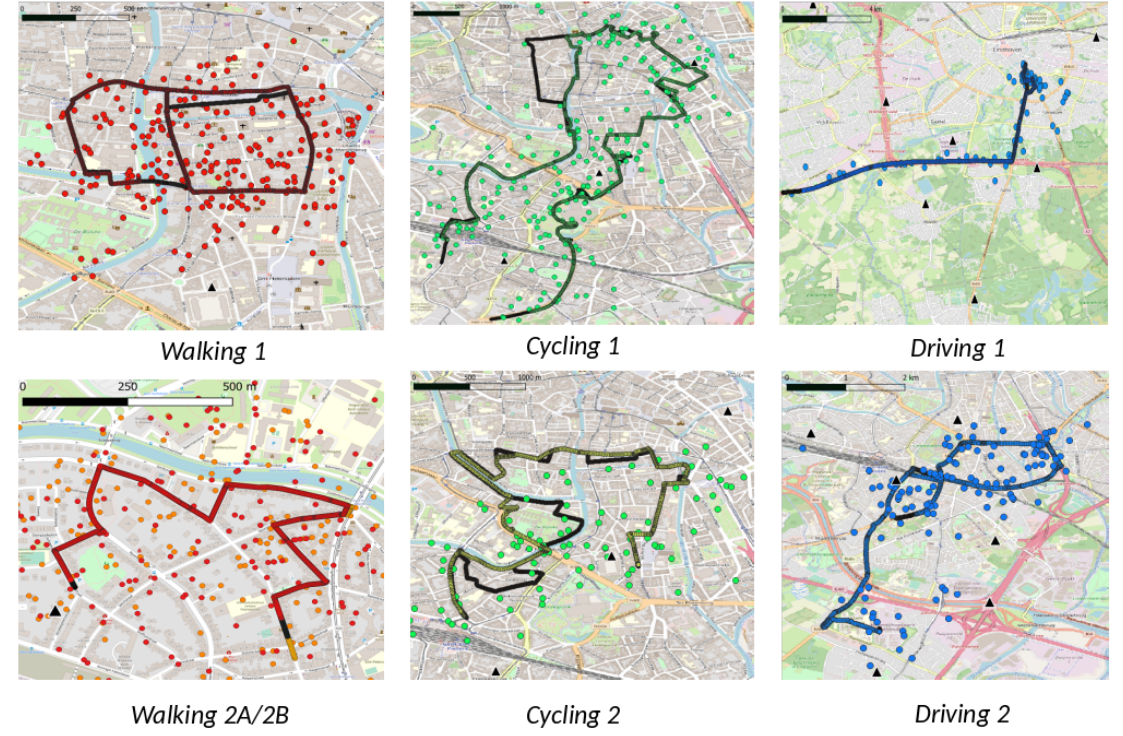
Figure 2. Trajectories with different mobility: left (walking), middle (cycling), and right (driving). The black trace denotes the ground truth. Localization by raw TDoA is shown as coloured dots. Gateways are shown as black triangles. The colored trace is the final result of combining TDoA and absolute compass heading in the map matching algorithm (Scenario OC-Abs.